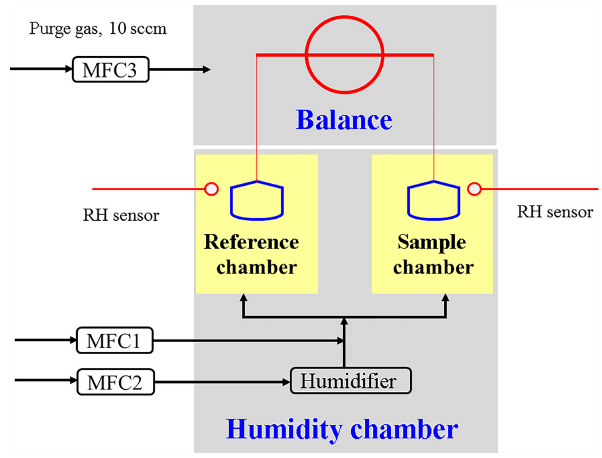
Figure 1. Schematic diagram of Q5000SA used in this work. MFC: mass flow controller. High-purity N 2 is used for all the three gas flows regulated by MFC1, MFC2, and MFC3,